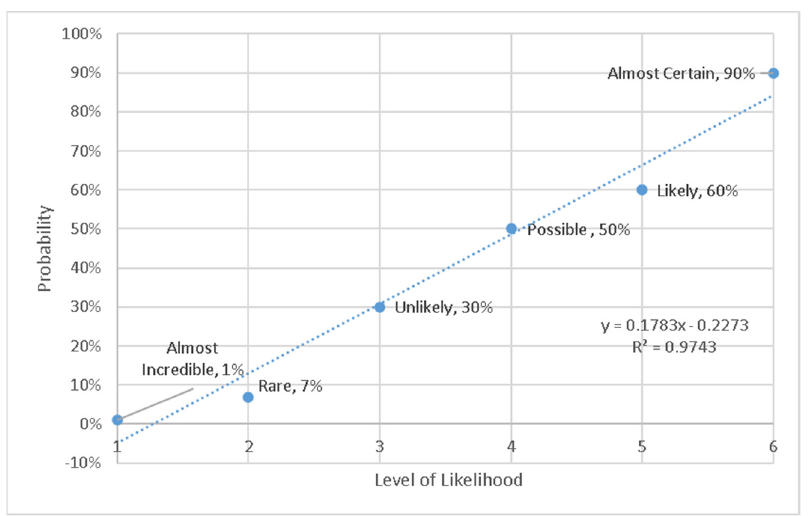
Figure 3. Revised DQL instrument.